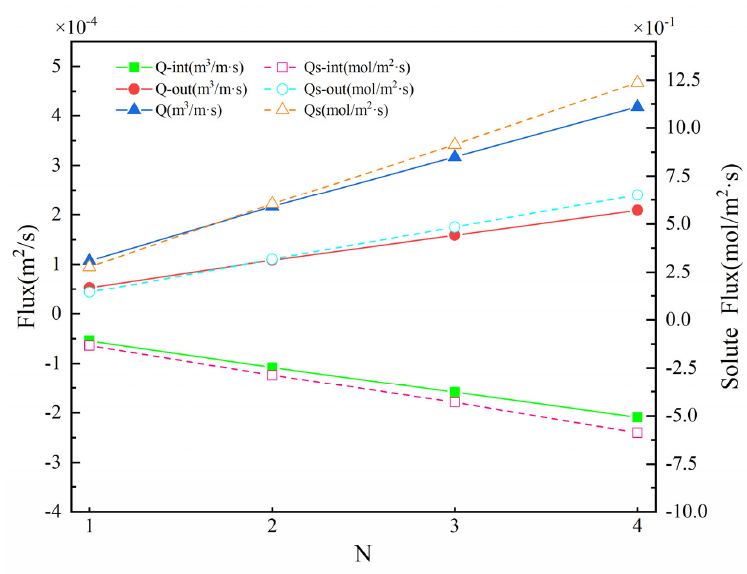
Figure 12. Vertical hyporheic exchange flux (Q), downwelling hyporheic flux (Q int ), upwelling hyporheic flux (Q out ), solute flux (Qs), downwelling solute flux (Q s-int ), and upwelling solute flux (Q s-out ) under different N values. The solid lines represent the hyporheic exchange flux; the dashed lines show the solute flux.